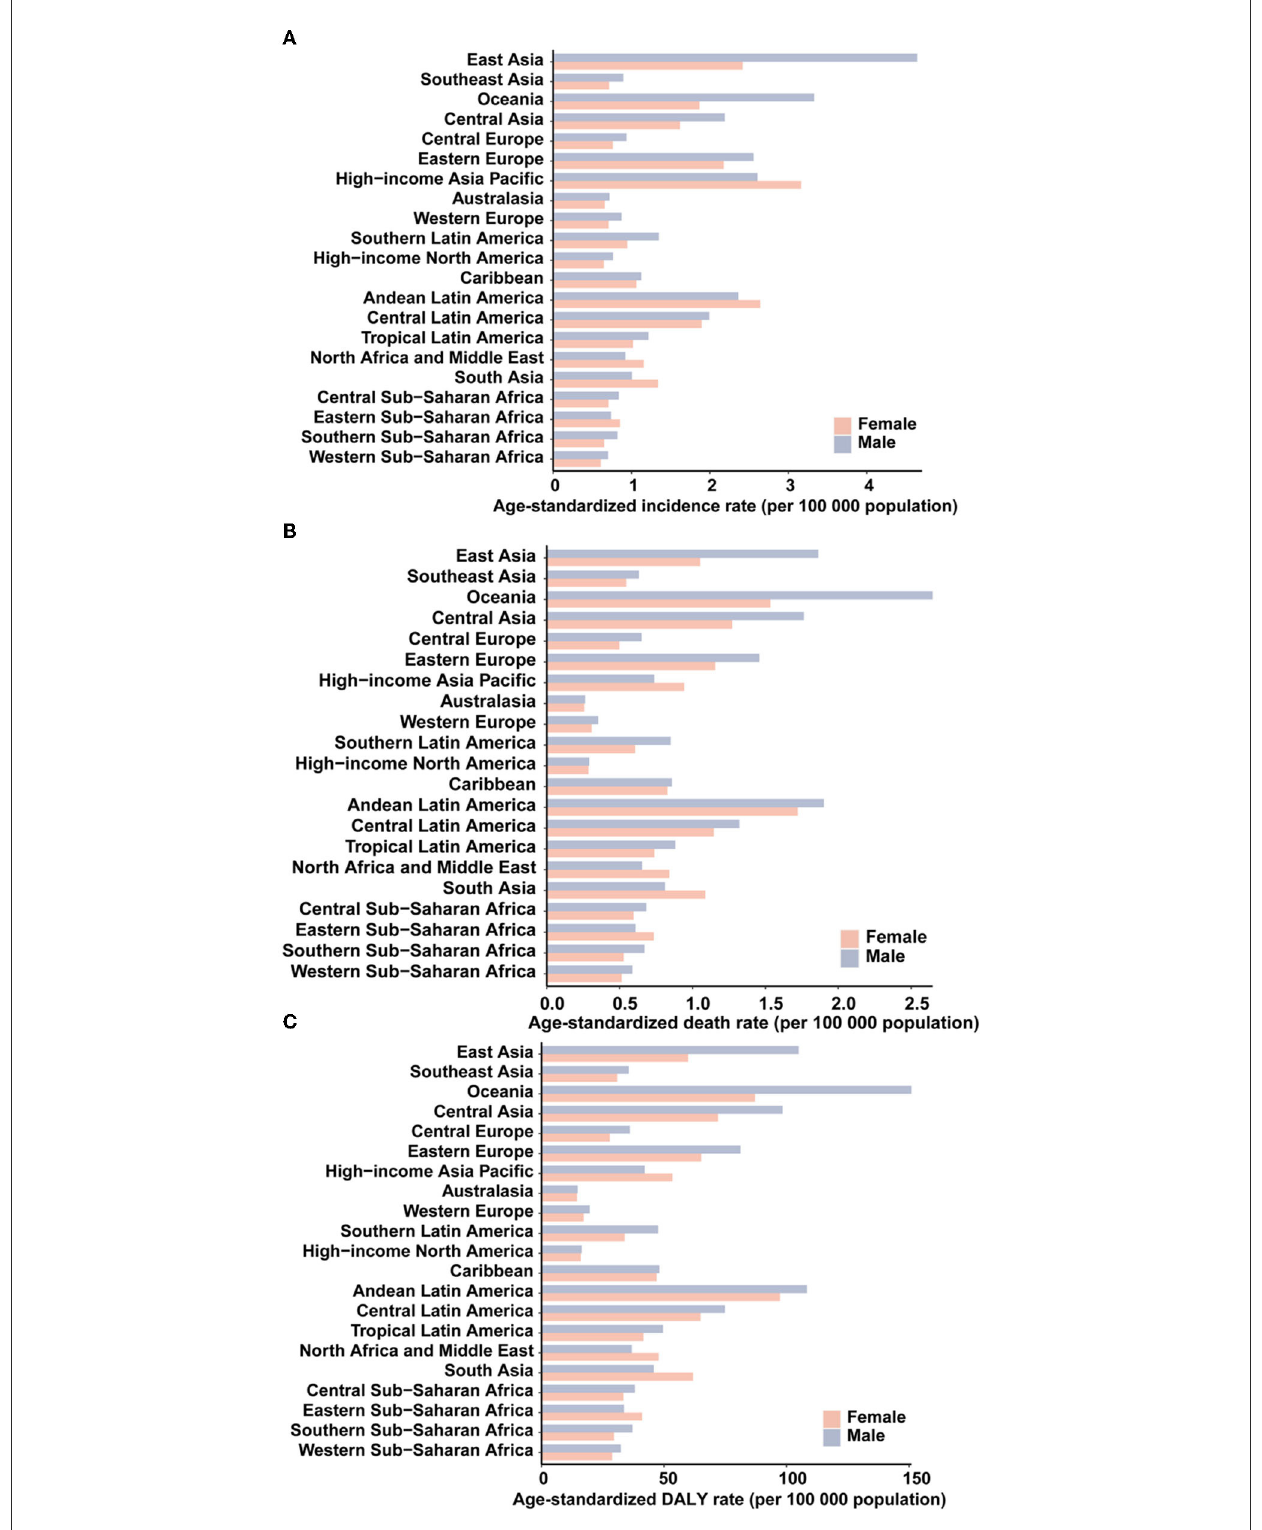
FIGURE2 The age-standardized incidence (A) , death (B) , and DALY (C) rates of stomach cancer in 2019 for 21 GBD regions, by sex.